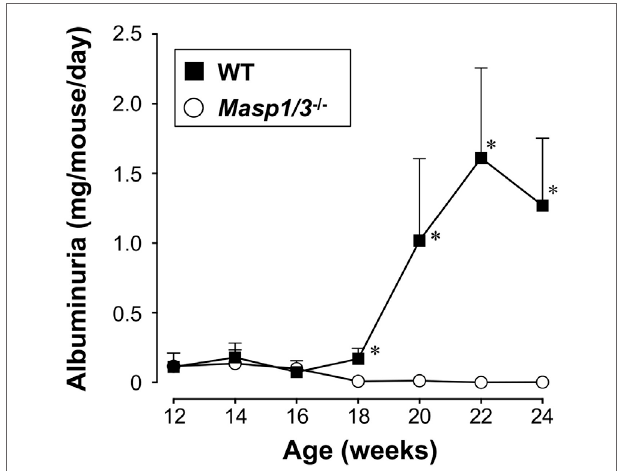
FigUre 4 | Urinary albumin excretion levels in 12- to 24-week-old MRL /lpr mice. Values are means ± SD ( n = 6–8). Values with asterisks are significantly